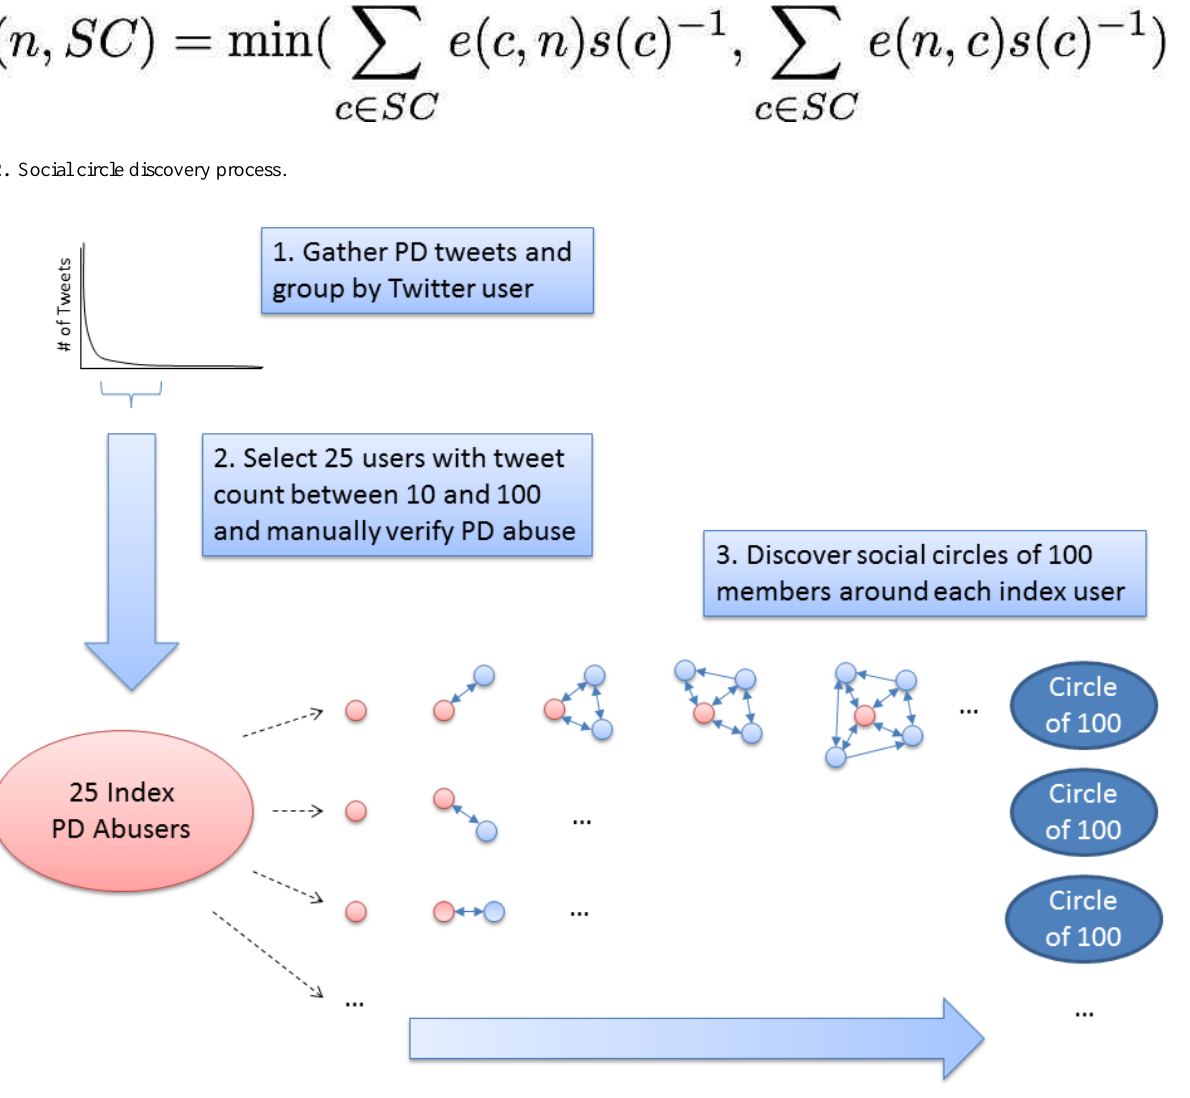
Figure 1. Local social circle discovery measure.